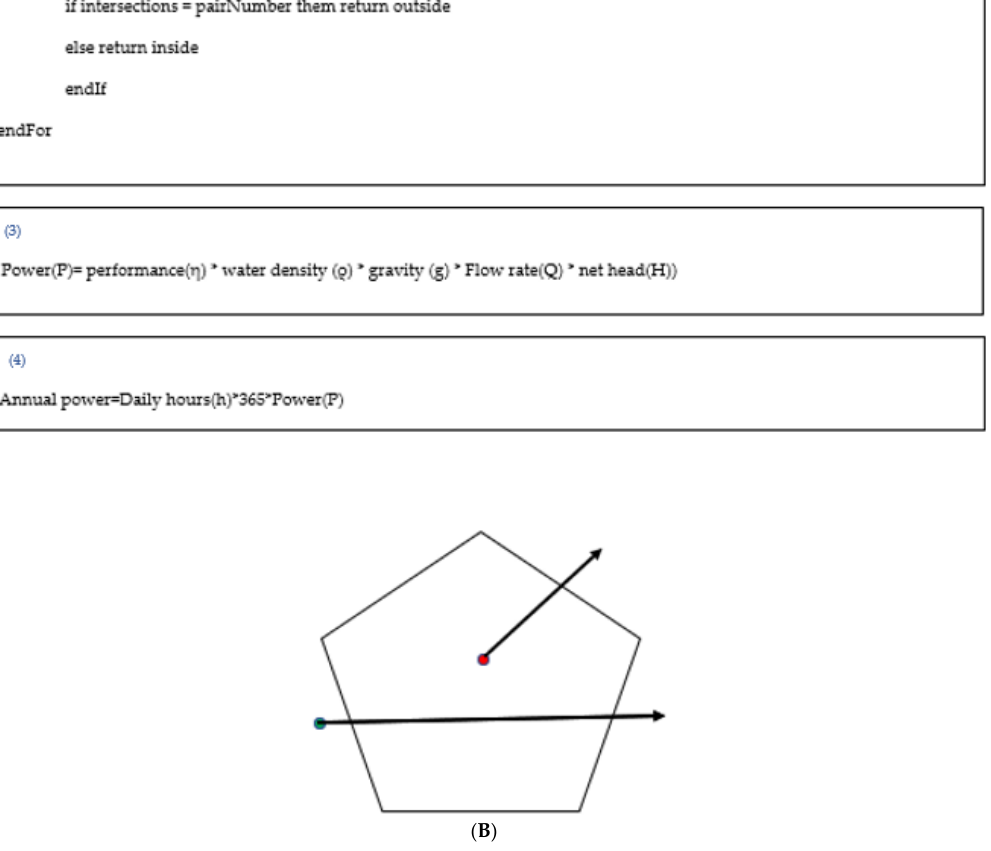
Figure 2. ( A ) Flowchart that describes the steps of the computer program developed. ( B ) Flowchart that describes the steps of the computer program developed. The program pulls a line from a point in any direction, with which you can tell if that point is inside or outside the section (Figure 2B). To do this, you have to look at the number